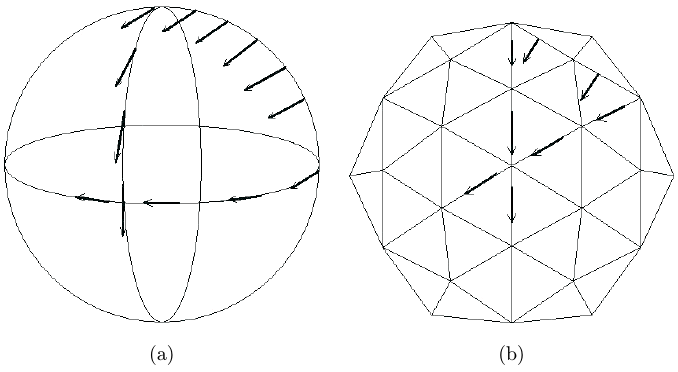
Fig. 4. Tangent vector parallel transport on a di®erentiable sphere and on a sphere consisting of